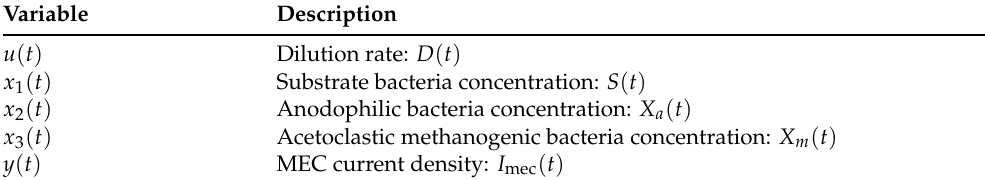
Table 2. Mathematical model variables.